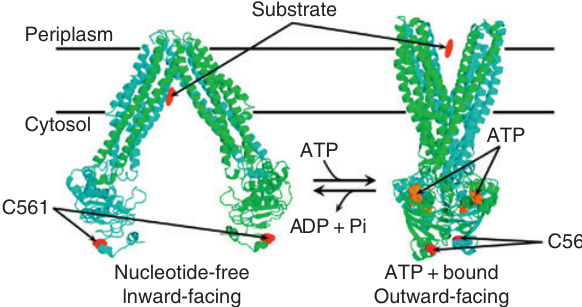
Figure 2: Alternate accessibility model with large conformational changes. Inward- and outward-facing MsbA X-ray structures. Binding of nucleotide (orange spheres) produces an association of the nucleotide-binding domains, which results in the rota- tion of transmembrane helices and switching of the opening of the substrate-binding pocket from one side of the membrane to the other. Each MsbA monomer is shown in a different color and the positions of the C561 residues are shown as red spheres. The approximate boundaries of the membrane are shown by the lines, and a transported substrate is shown as a red oval. In the case of MsbA, the substrate is lipid A, which the protein translocates from the inner to the outer leaflet of the